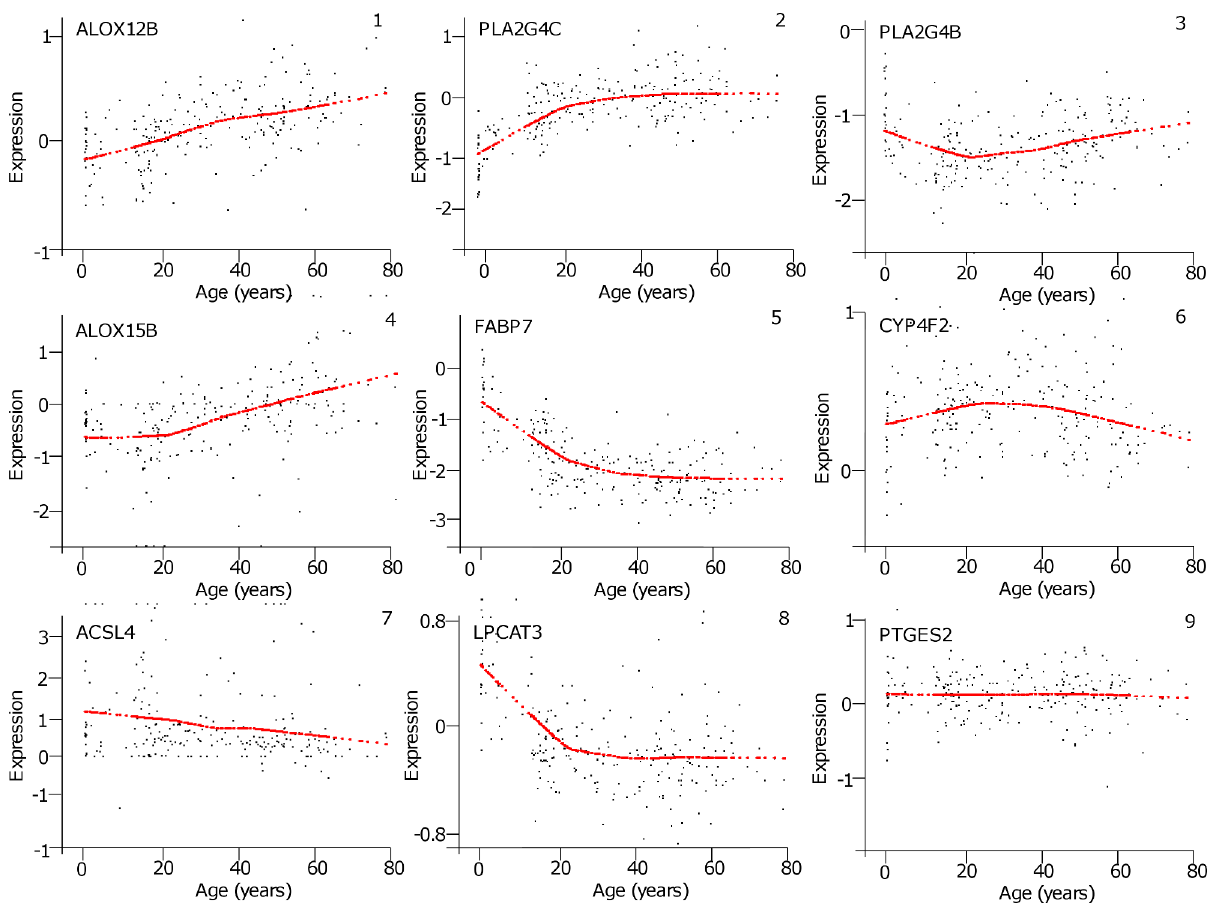
Figure 1. Representative expression patterns. Graphs were exported directly from BrainCloud. Representative graphs for patterns 1–9 shown here are identified by an example gene. Expression patterns of all genes included in the study are shown in Table 1. The first expression pattern increases at a relatively equal rate throughout life, while the seventh pattern decreases at a relatively equal rate throughout both intervals. Pattern 2 increases sharply during Development then the increase slows during Aging; pattern 5 is the opposite with a sharp decrease during development and a gradual decrease during aging. Pattern 3 decreases during Development, then increases during Aging and pattern 6 increases during Development then decreases during Aging. Pattern 4 remains steady during Development then increases during Aging. Pattern 8 decreases during Development then doesn’t change during Aging. Pattern 9 shows minimal changes during both intervals. The units for the y-axes are log 2 (Sample/ Ref). A two-fold change in gene expression occurs at one and negative one on the y-axis. The y-axes are not all